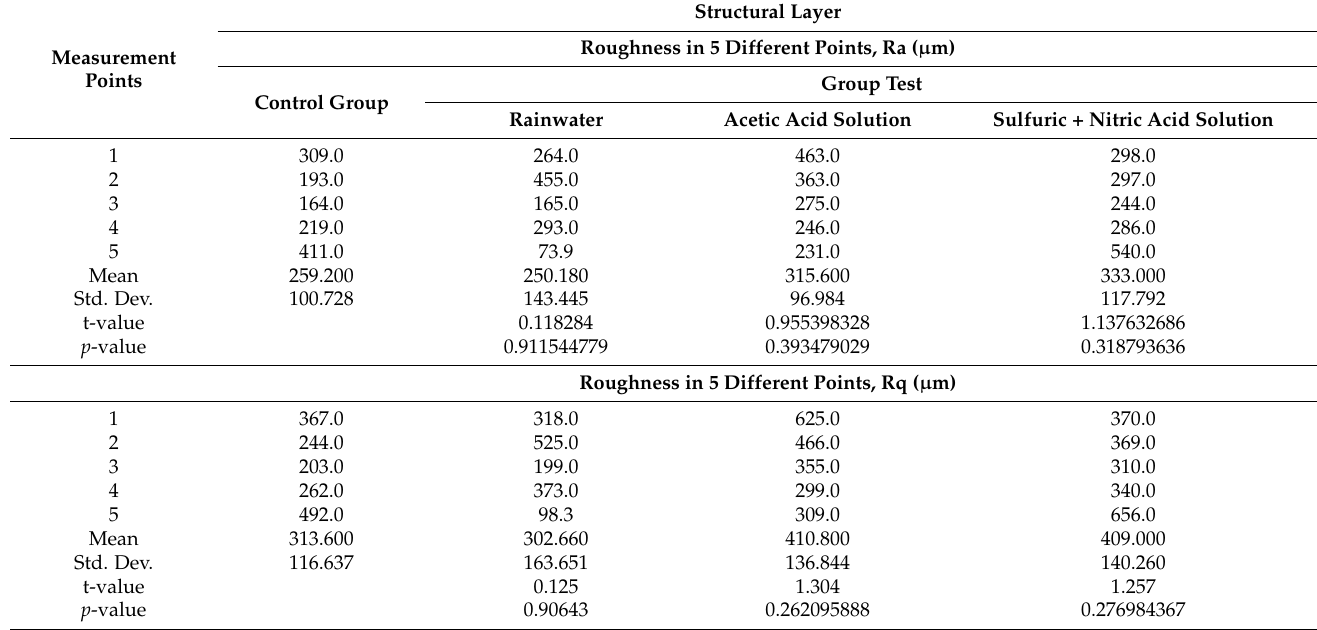
Table 3. The roughness table for structural